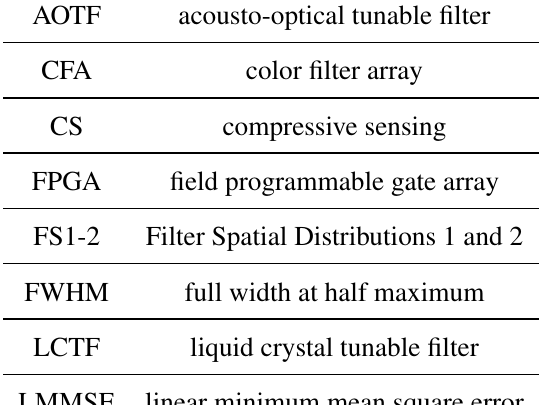
Table 1. List of acronyms used in the